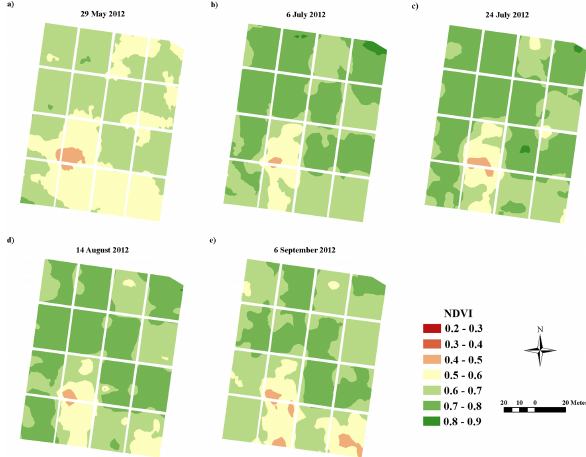
Figure 8. Interpolated NDVI maps of 2012 growing season: (a) 29 May; (b) 6 July; (c) 24 July; (d) 14 August; and (e) 6 Septem- ber.